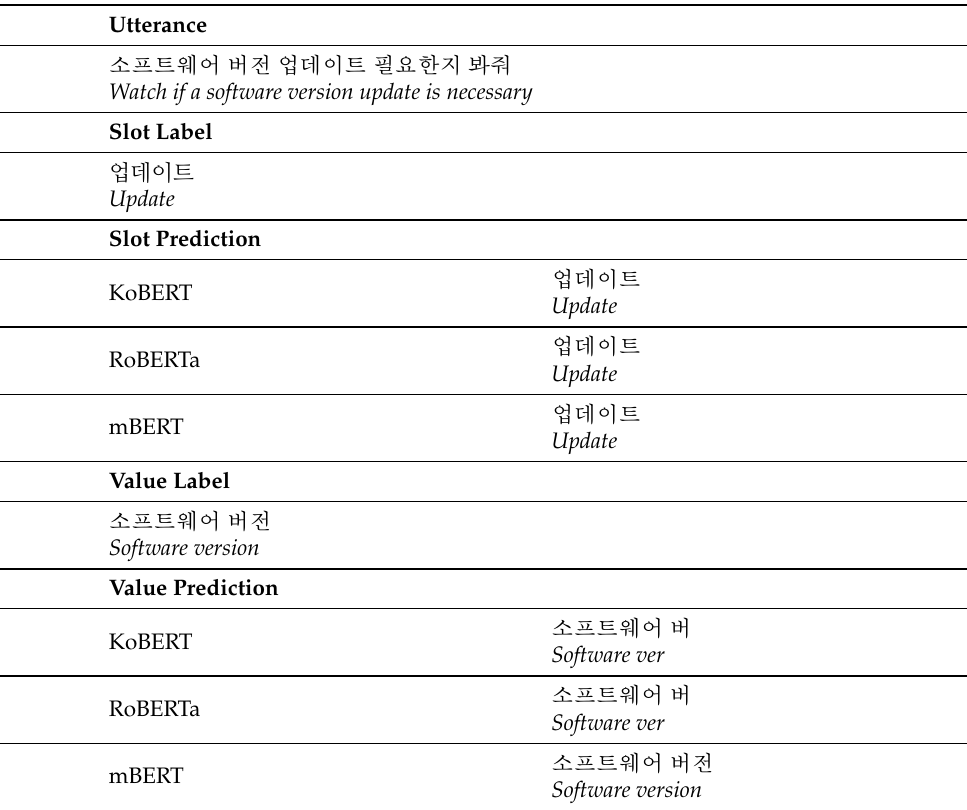
Table 6. Qualitative result for slot-value predicted.